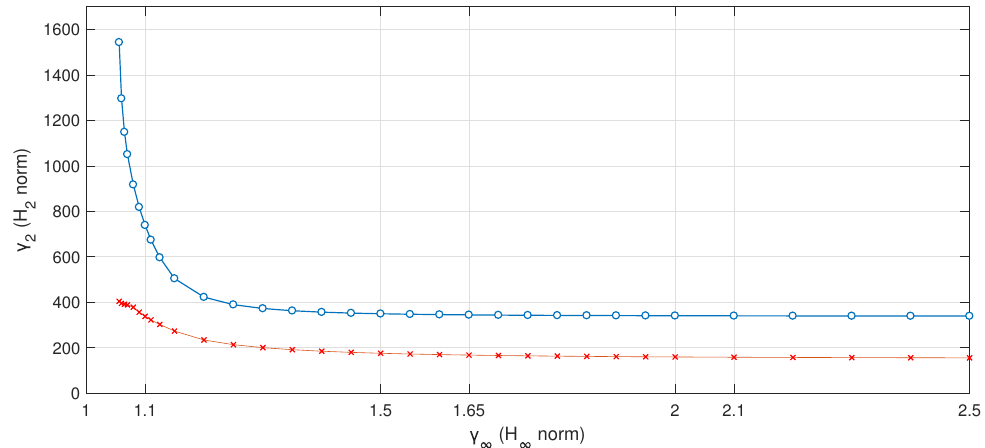
Figure 3. Graph of obtained Pareto curves for the studied control system. Blue line—Matlab algorithms, red line—calculations using YALMIP and SeDuMi libraries with LMI conditions